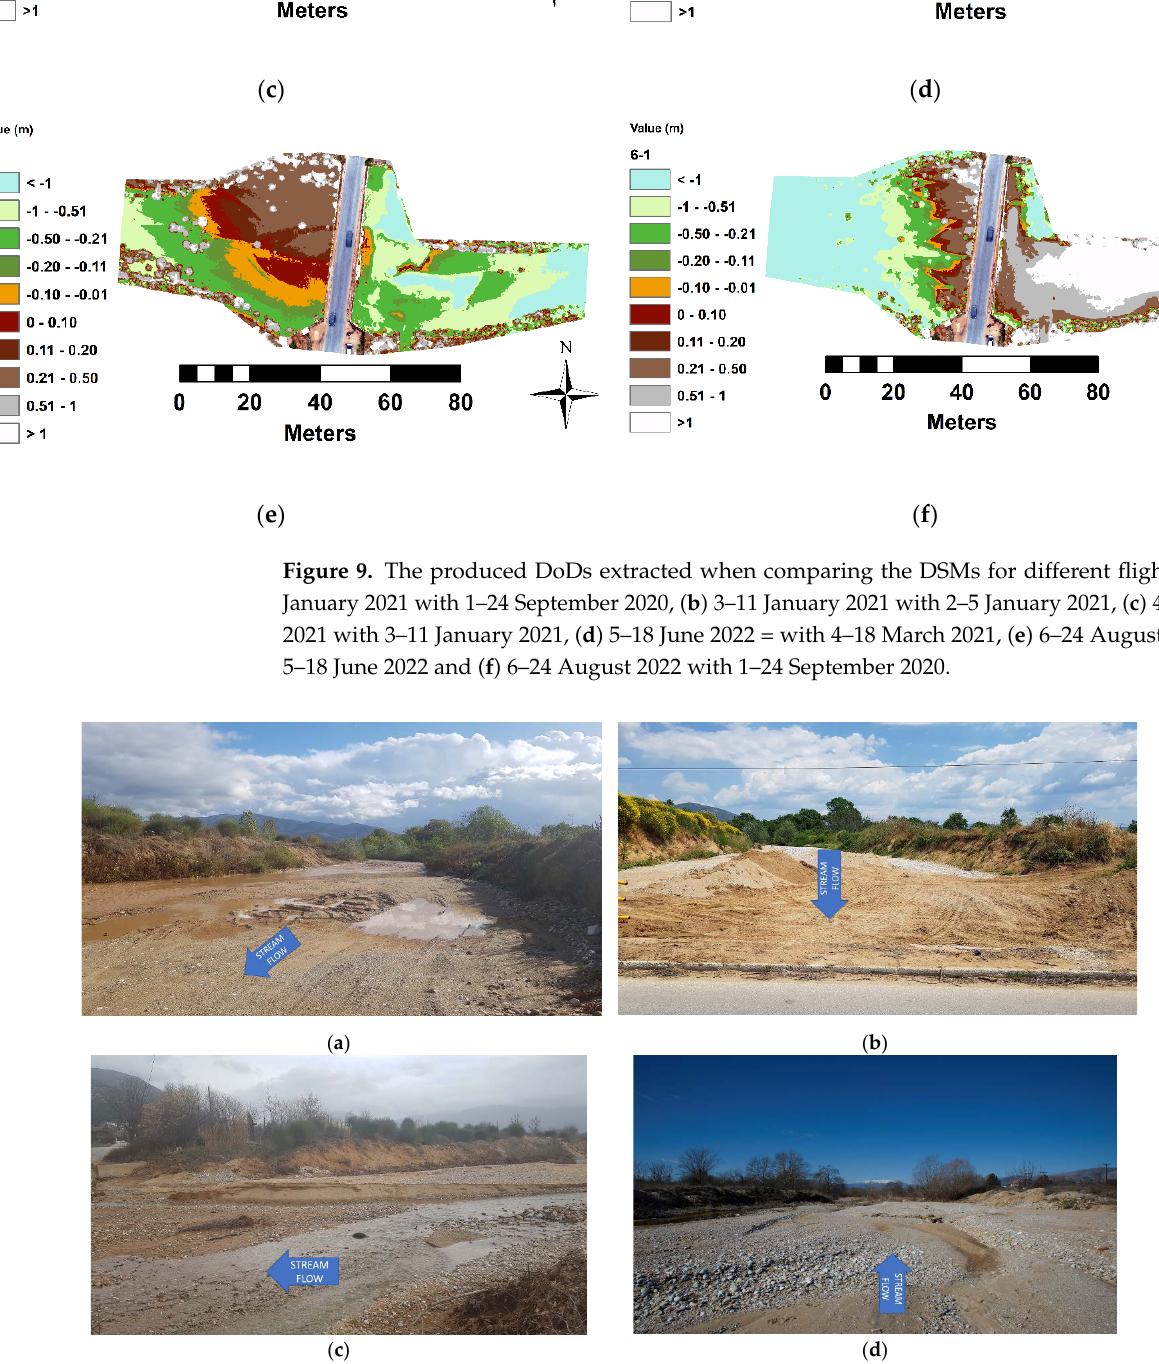
( h ) Figure 10. The Kallifitos torrent: ( a ) a field of view from the bed of the excavated material on 13 October 2020, ( b ) a field of view from the bed of the excavated material on 2 June 2022 (tire tracks are also visible), ( c ) a field of view from the bed of the deposition material on 8 February 2021, ( d ) a